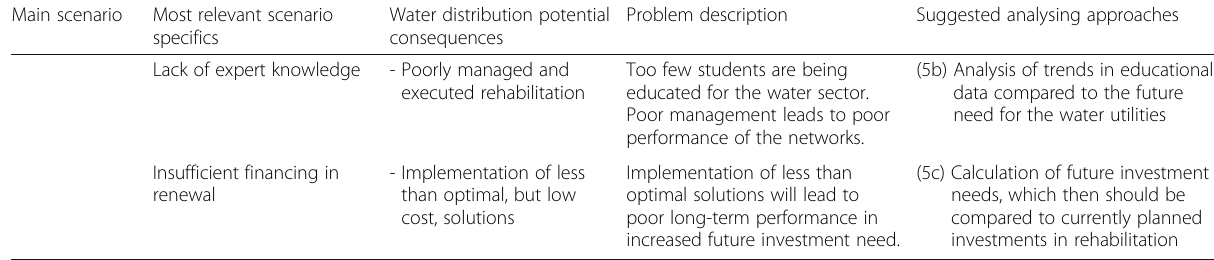
Table 3 Relevant future scenarios, potential consequences and analysing approaches identified in the case study